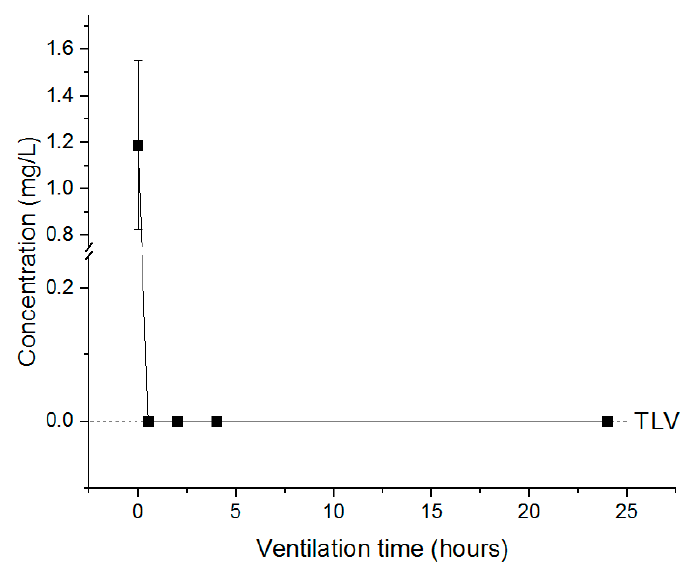
Figure 7. The concentration of PH 3 inside the desiccator under resealed conditions. Each value represents the mean ± SE ( n = 3).